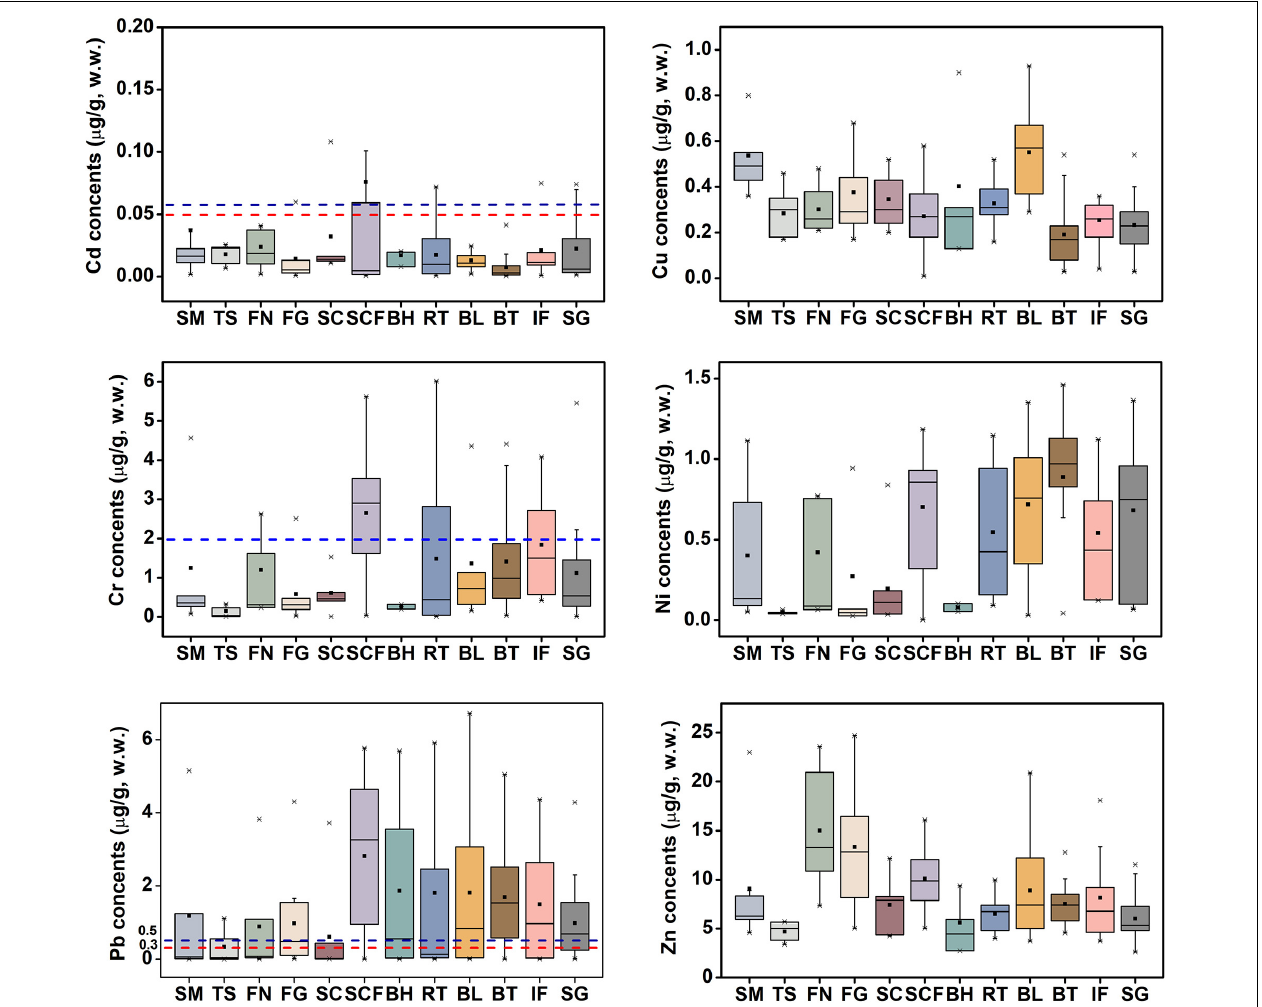
FIGURE 2 | Concentrations ( µ g/g, w.w.) of trace metals in muscle tissue of marine fish from Liaodong Bay. Red dotted line – the maximum permissible levels for fish proposed by European Union Commission Regulation; Blue dotted line – the maximum permissible levels for fish proposed by Ministry of Health of the People’s Republic of China (Ministry of Health of the People’s Republic of China [MHPRC], 2017). SM: Spanish mackerel; TS: Tongue Sole; FN: Flat needlefish; FG: Fang’s gunnel; SC: Sea chub; SCF: Sea catfish; BH: Bastard halibut; RT: Robust tonguefish; BL: Bluefin leatherjacket; BT: Black tetra; IF: Indian flathead; SG: Shokihaze goby.